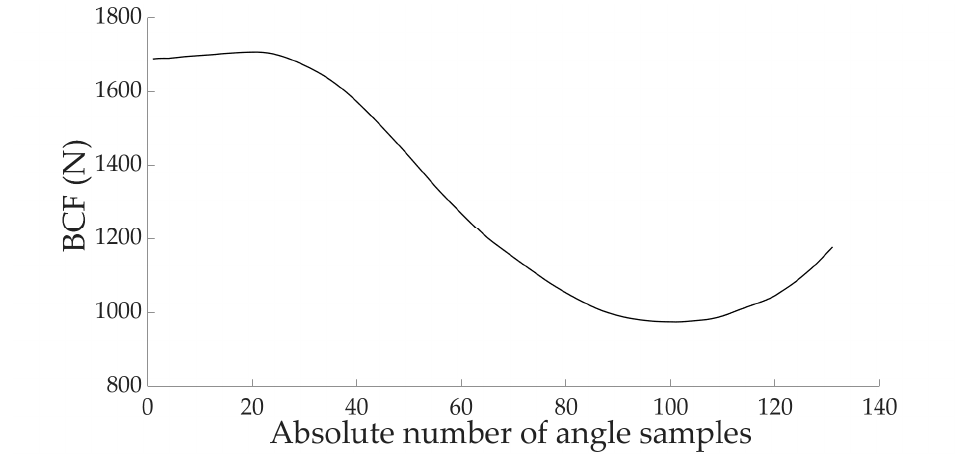
Figure 3. BCF (group mean) from inertial sensor semi-automation method between origin and